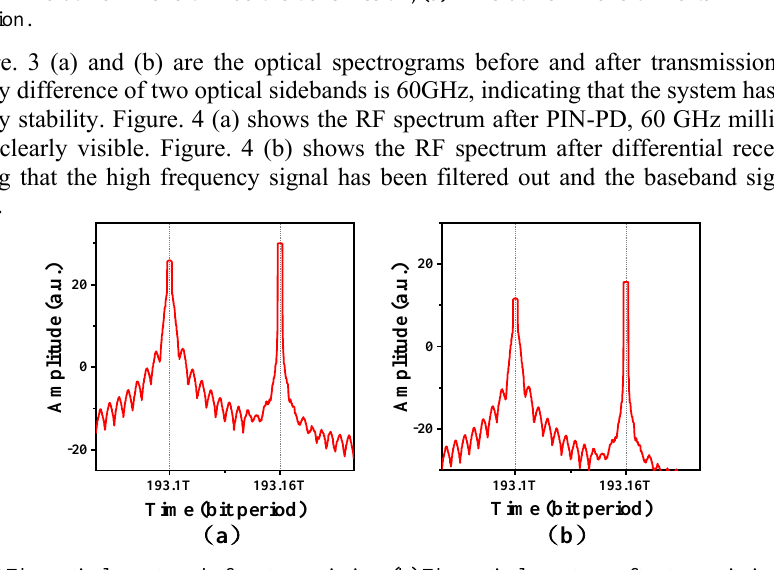
Fig. 3. (a) The optical spectrum before transmission; (b) The optical spectrum after transmission.